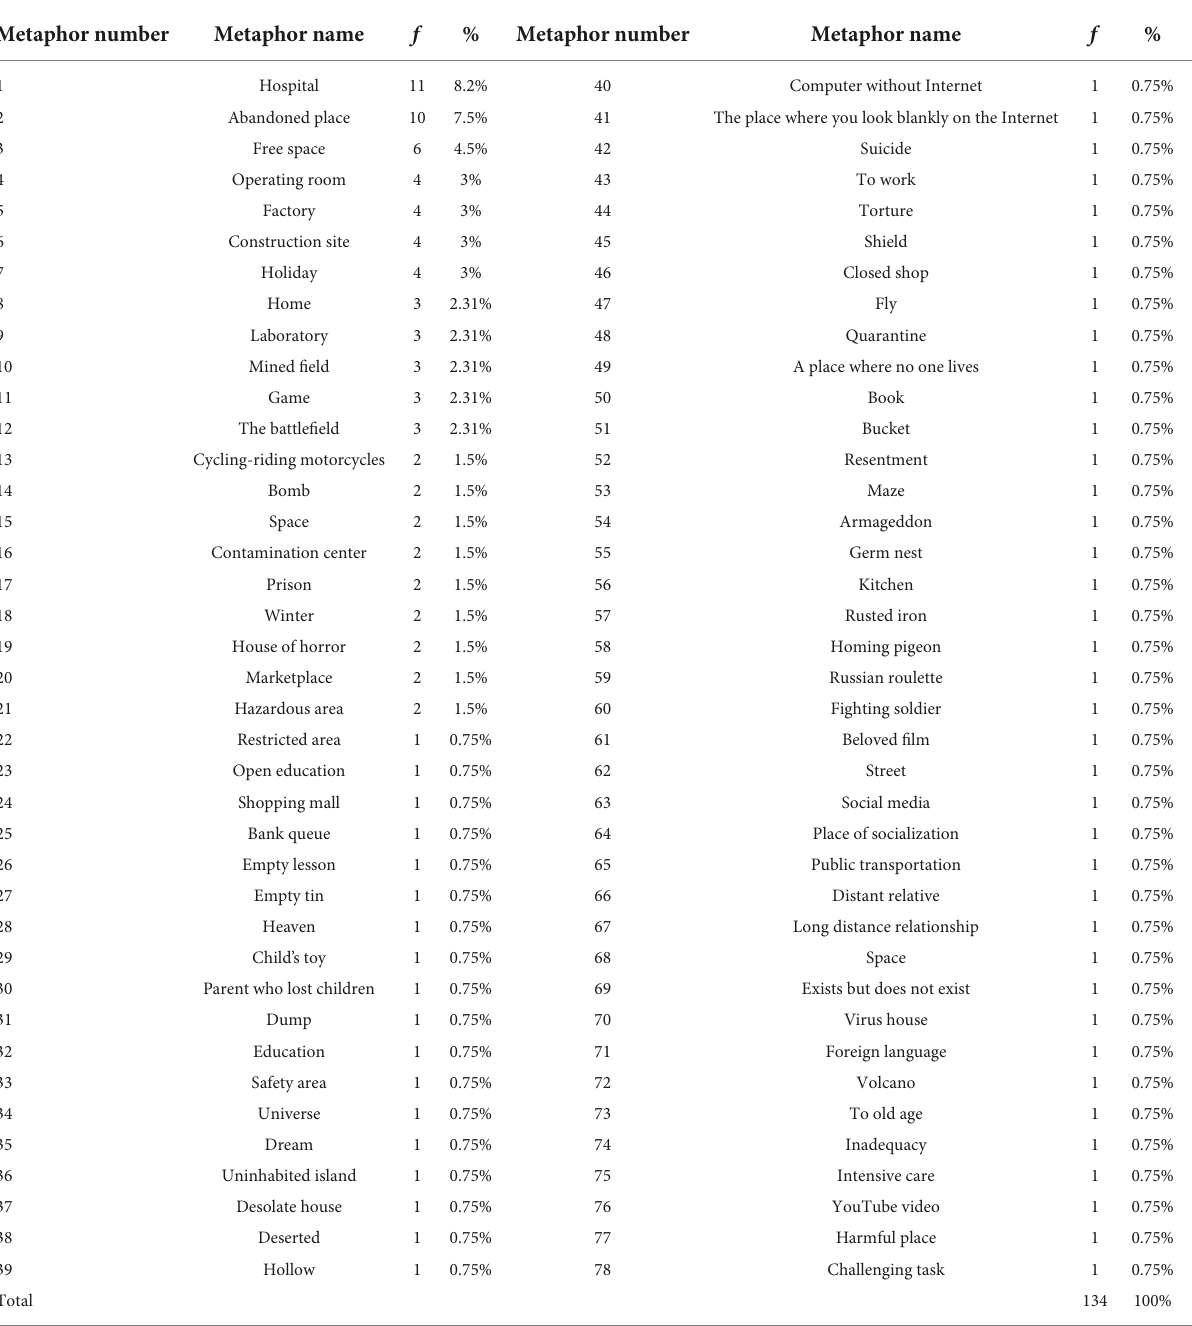
TABLE 10 Metaphors created by the students for the concept of “school in this